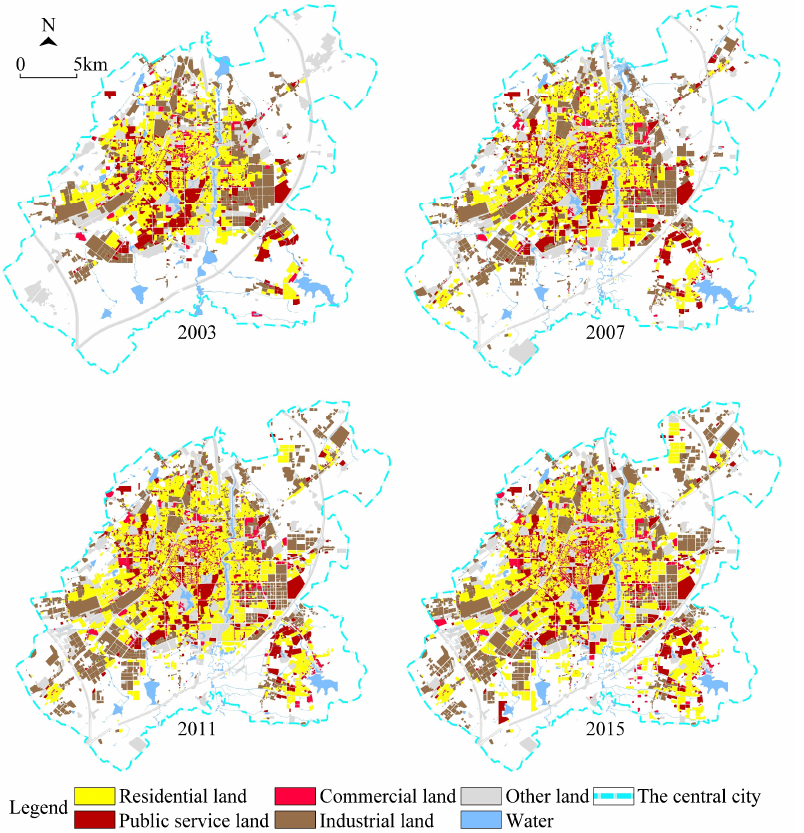
Figure 3. Urban land use maps of the central city (2003, 2007, 2011, and 2015).